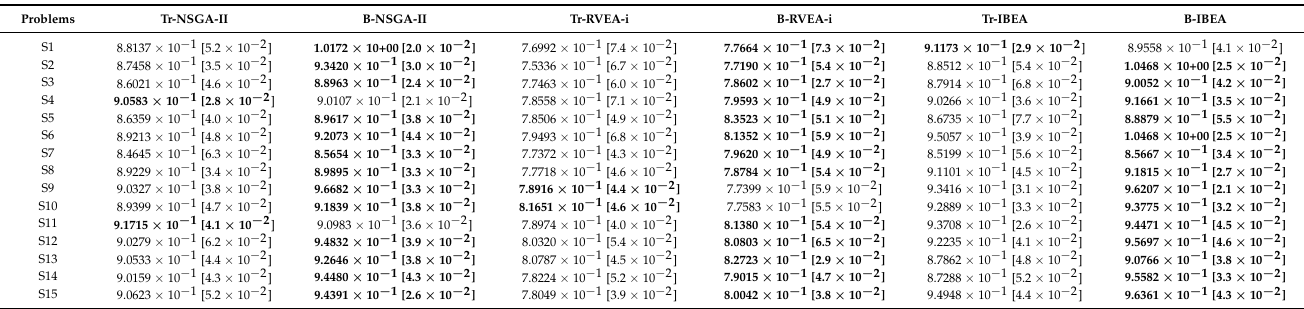
Table 8. Mean and standard deviation values of the MHV metric obtained by comparing algorithms for small-scale instances.